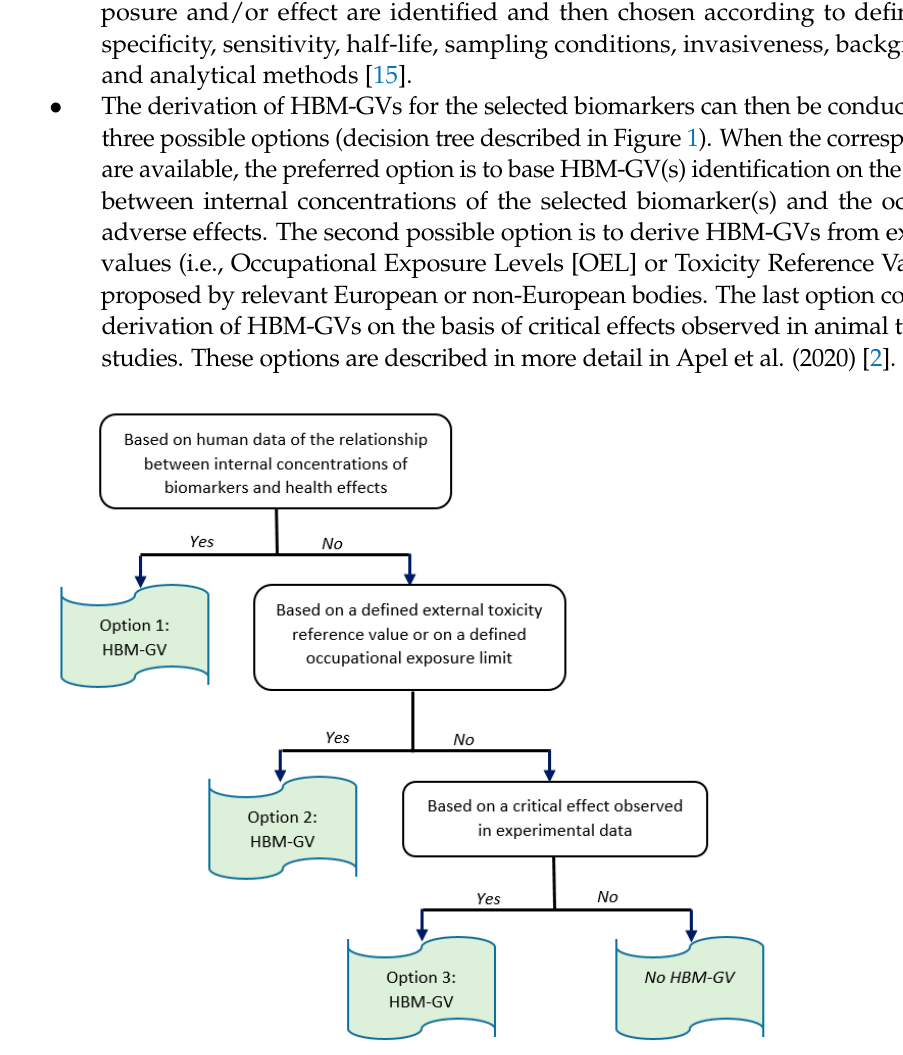
Figure 1. Decision tree for determining